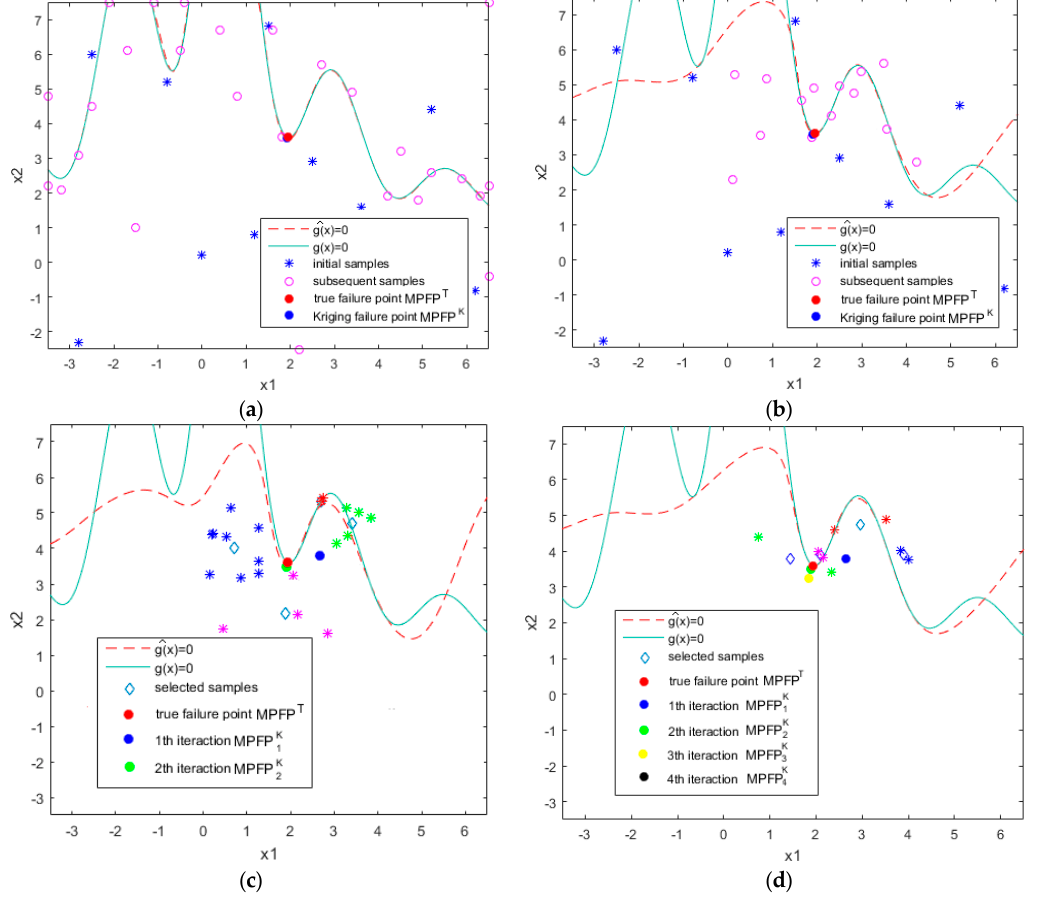
Figure 3. ( a ) The efficient global reliability analysis (EGRA) sampling method; ( b ) the local approximation method; ( c ) result of local approximation and clustering in Iteration 2; ( d ) result of local approximation and clustering in Iteration 4. Table 1. Results of the reliability analysis of Example